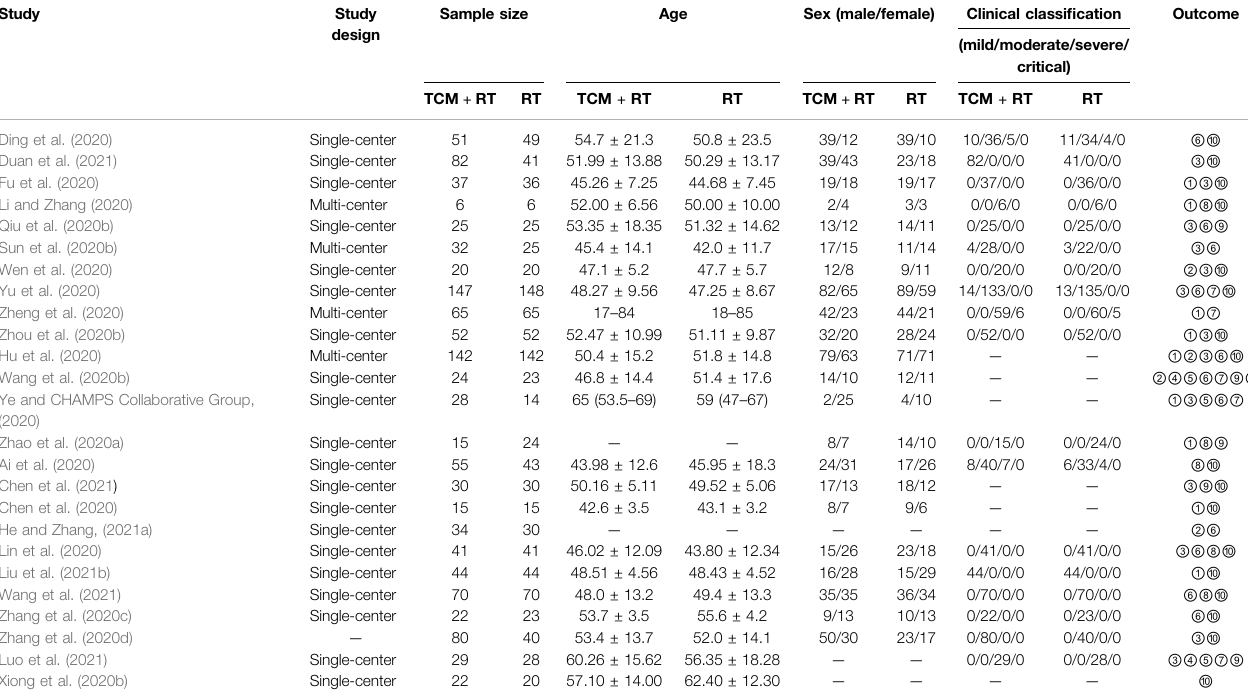
TABLE 1 | Study design, population ’ s details, and outcome of selected